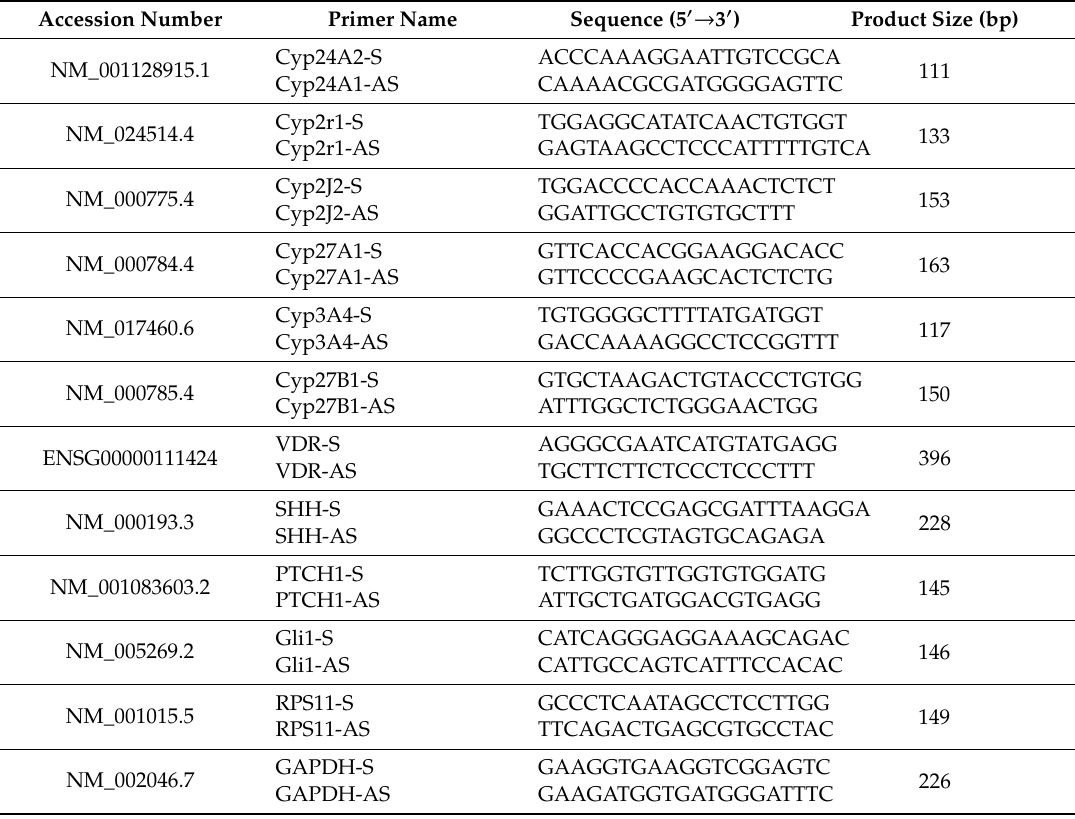
Table 1. Primer sets used for RT-PCR and